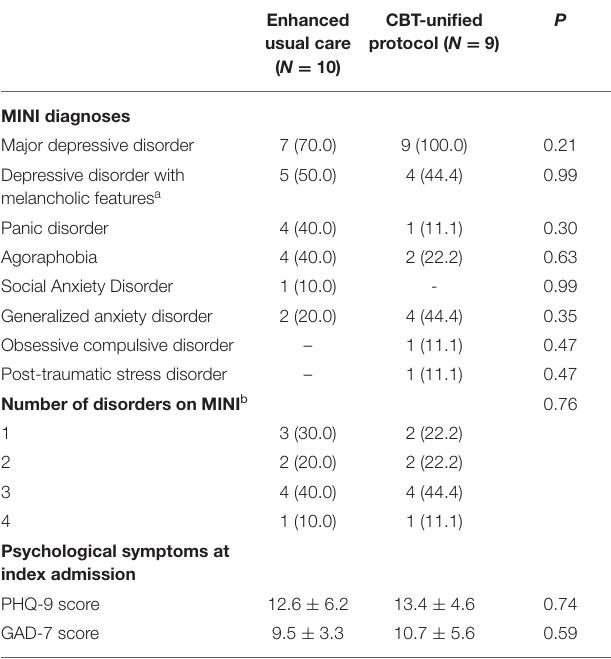
TABLE 2 | Baseline mental health characteristics of the